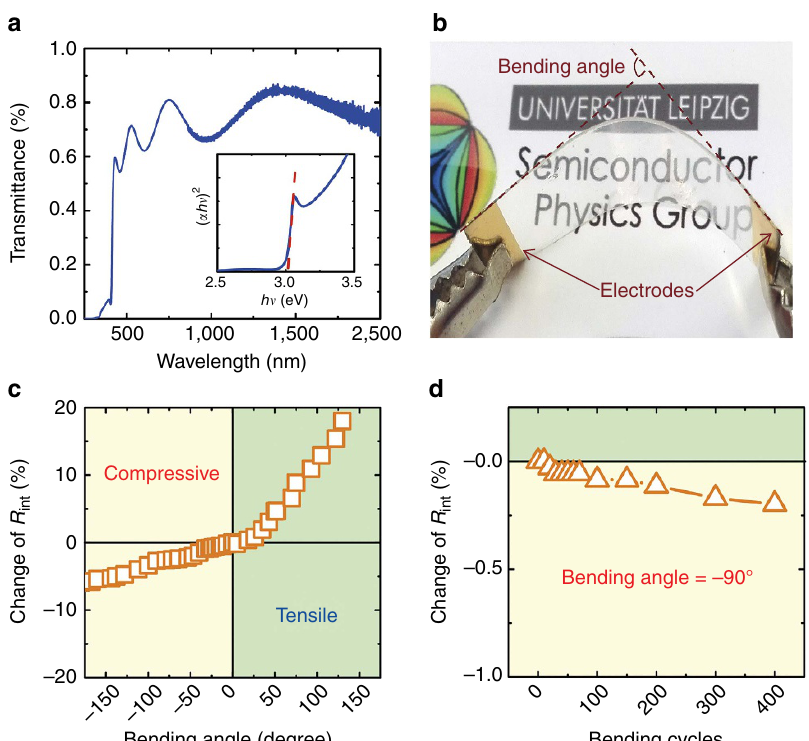
Figure 2 | Transparency and flexibility of the CuI thin films. ( a ) Transmittance spectra of CuI thin film (thickness of 300nm) deposited on glass. Inset is the ( a h n ) 2 versus h n plot of CuI thin film. ( b ) The actual photo and ( c ) internal resistance R int stability of a CuI thin film sample deposited on PET with different bending angles. ( d ) The reliability test by repeated bending